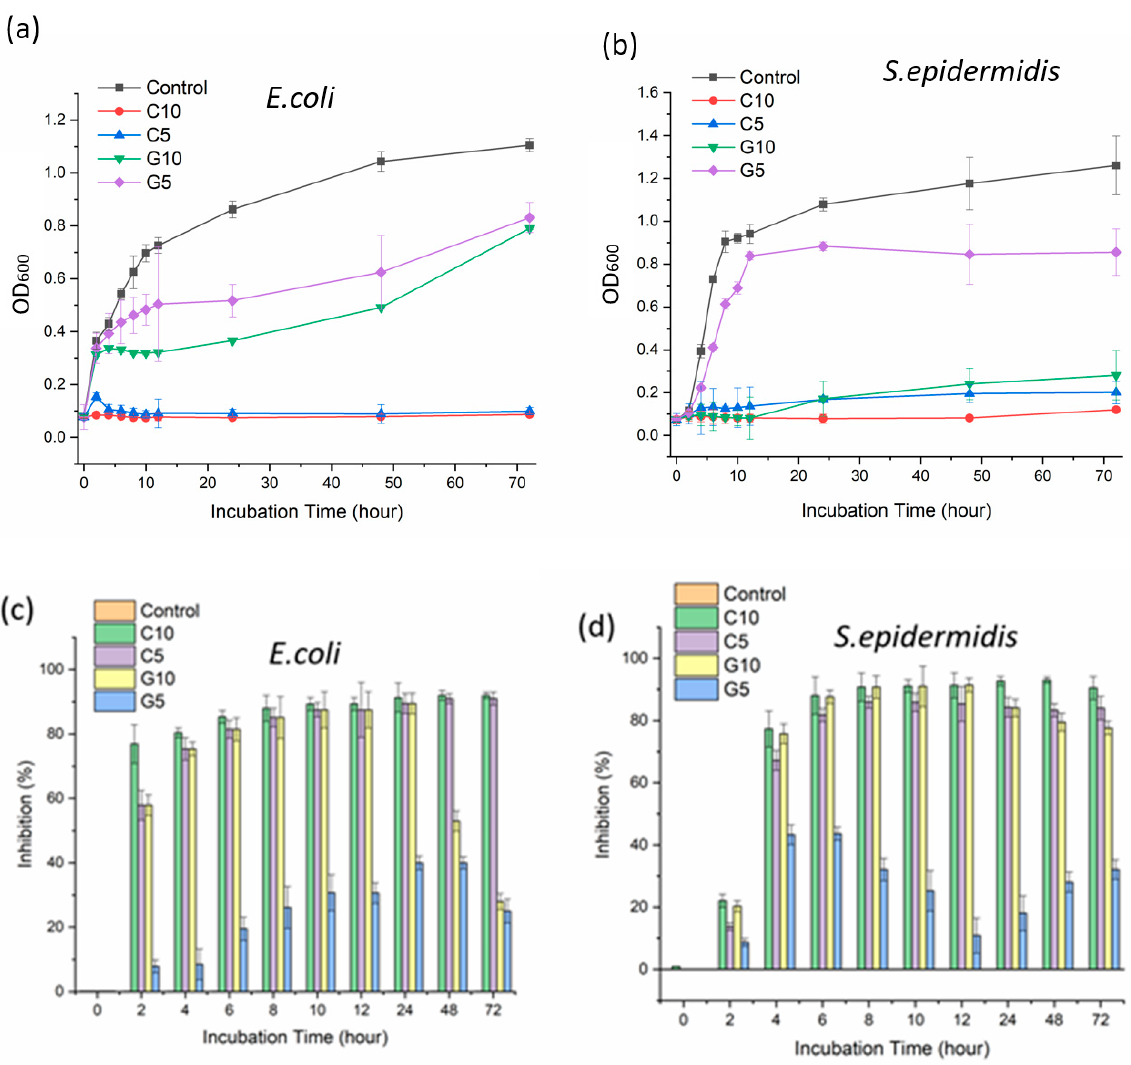
Figure 7. Bacterial growth kinetic curves of carvacrol or geraniol-loaded PLA nanofibers for a 72 h incubation time against ( a ) E. coli and ( b ) S. epidermidis , and ( c ) inhibition percentages (%) against E. coli and ( d ) S. epidermidis.